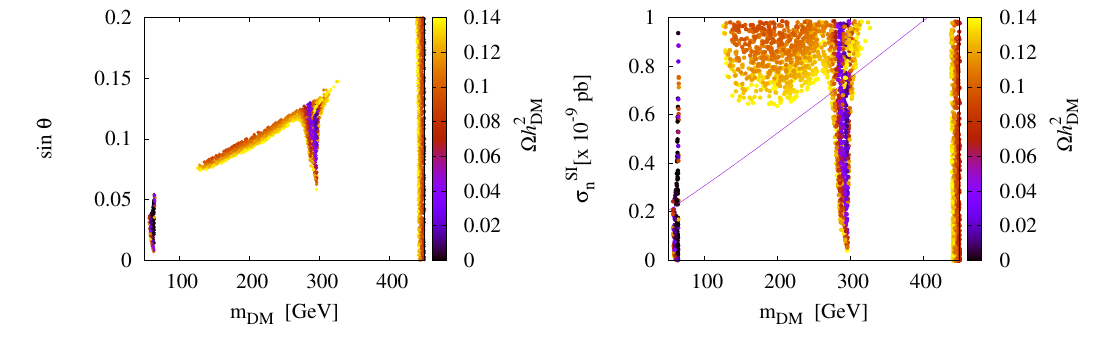
Figure 8 . In the left panel, the dependence of the relic abundance of ~ (cid:23) 1 has been shown on its mass and left-fraction. The right panel shows the allowed region respecting the direct detection constraint from XENON-1T